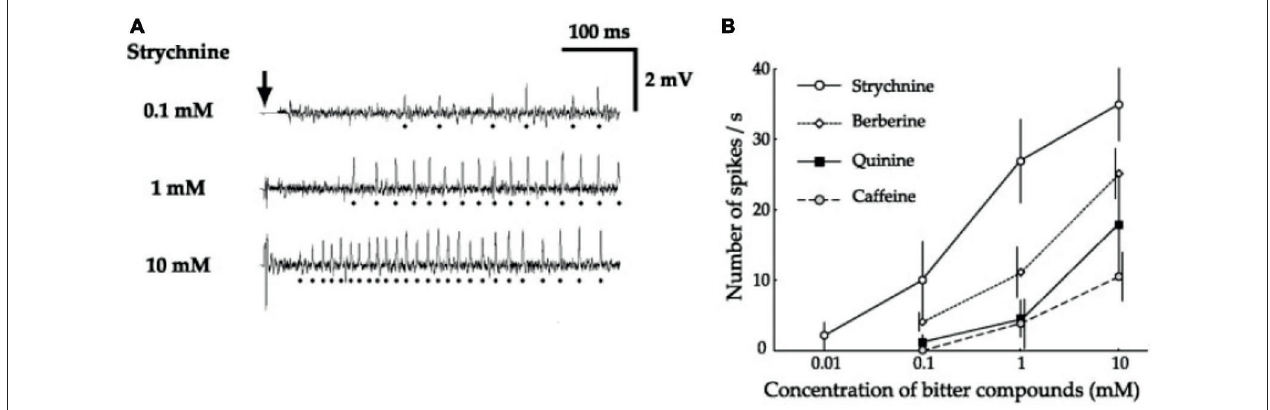
FIGURE 2 | Bitter-sensitive neurons are activated by bitter substances (from Hiroi et al., 2004). (A) Sample recordings from I-type sensilla stimulated with strychnine at increasing concentrations (0.1 mM, 1 mM, 10 mM), showing that one cell is activated by strychnine. (B) Dose response curves showing the response of this cell to increasing concentrations of strychnine (empty circle), berberine (empty diamond), quinine (black square) and caffeine (empty circle and dotted